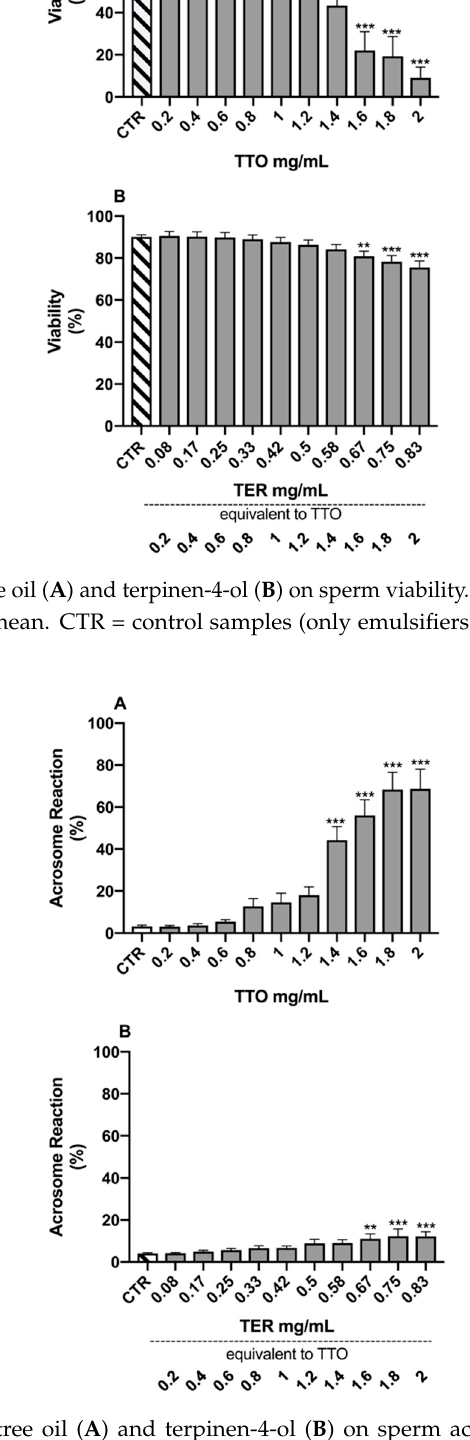
Figure 2. Effects of tea tree oil ( A ) and terpinen-4-ol ( B ) on sperm acrosome reaction. Data are expressed as mean ± standard error of the mean. CTR = control samples (only emulsifiers). ** = p < 0.01; *** = p < 0.001.